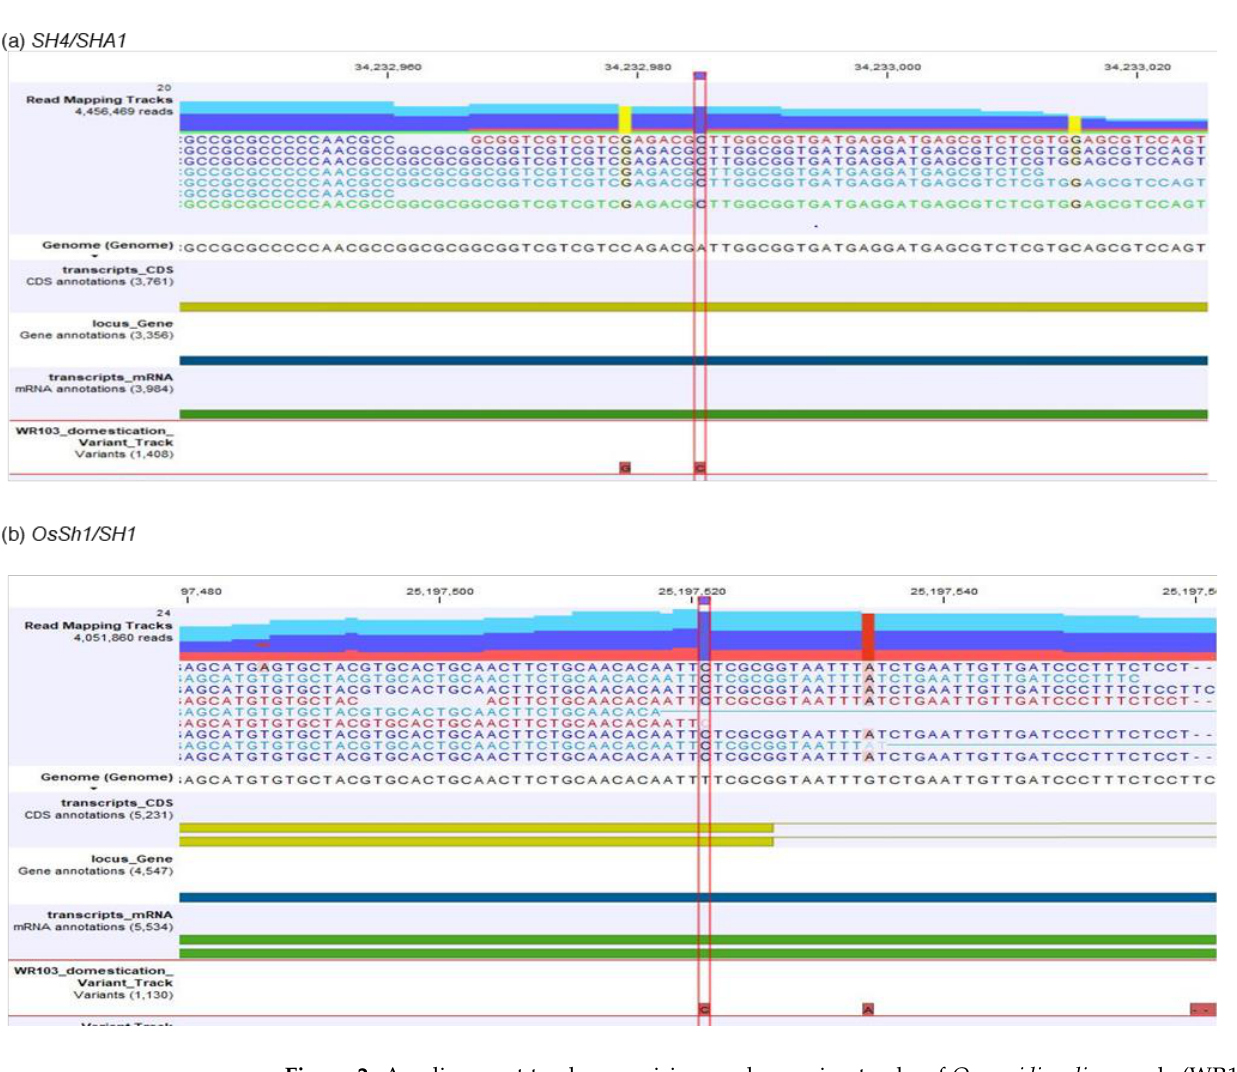
Figure 2. An alignment track comprising read mapping tracks of O. meridionalis sample (WR103) along with a reference genome, coding sequence annotation, gene annotation, mRNA annotation, and single nucleotide polymorphism track of WR103: ( a ) an alignment track of SHATTERING 4 ( SH4 / SHA1 ); ( b ) an alignment track of SHATTERING 1 ( OsSh1 / SH1 ).